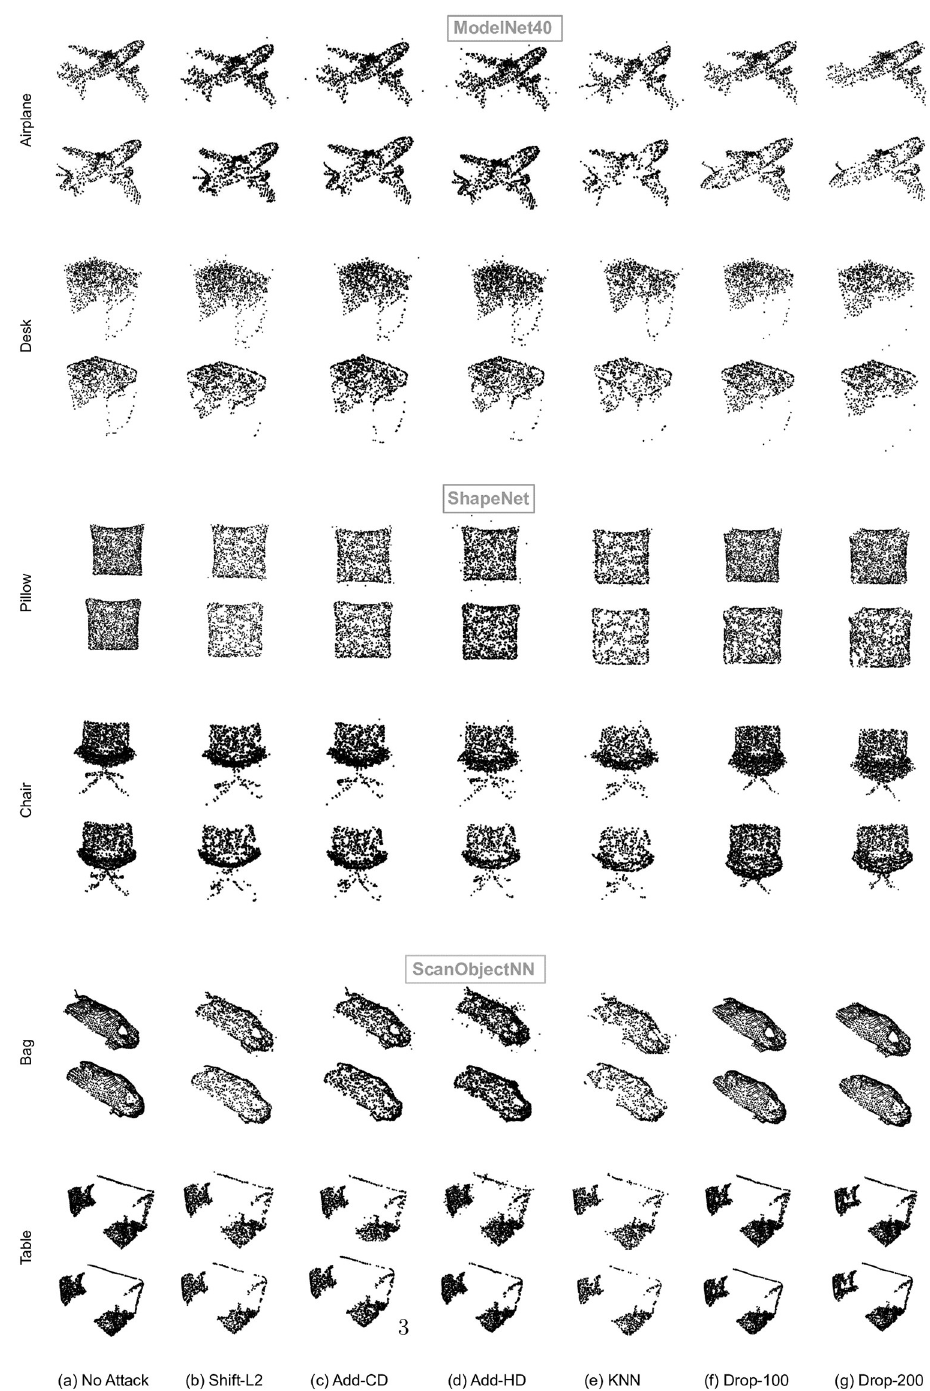
Fig 7. Effect of proposed low pass preprocessing on point cloud samples of three datasets Modelnet40, ShapeNet, and ScanobjectNN for different attacks. [Odd rows: Point clouds before preprocessing. Even rows: Point clouds after low pass filtering with S = 20. Preprocessing in (b), (c), and (d) is performed with a combination of low pass filtering and SOR.].